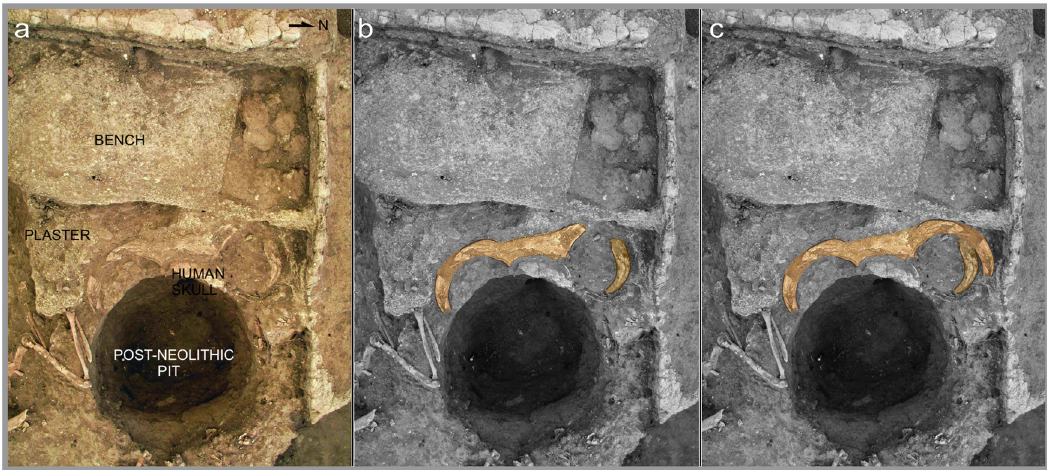
Figure 1: Cattle bucranium in burial: ( a ) excavation stage, ( b ) with an indication of cattle bucranium, along with which a female skeleton was found, and ( c ) reconstruction of complete cattle bucranium ( unit 11562, Space 248, TP Area, Level TP.R, Çatalhöyük East ) . ( Photo by T. Koz ł owski, modi fi ed )